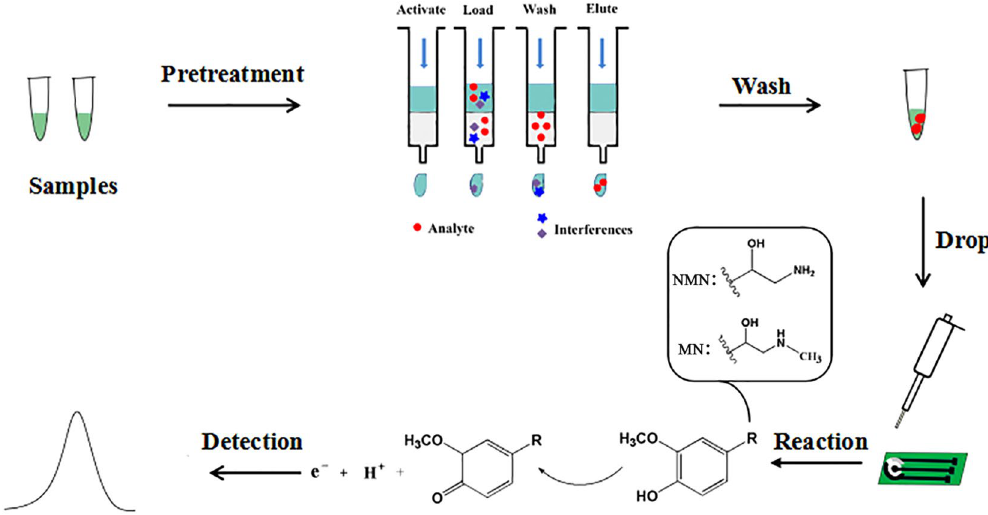
Figure 1. Schematic illustration of the experimental procedure performed on the